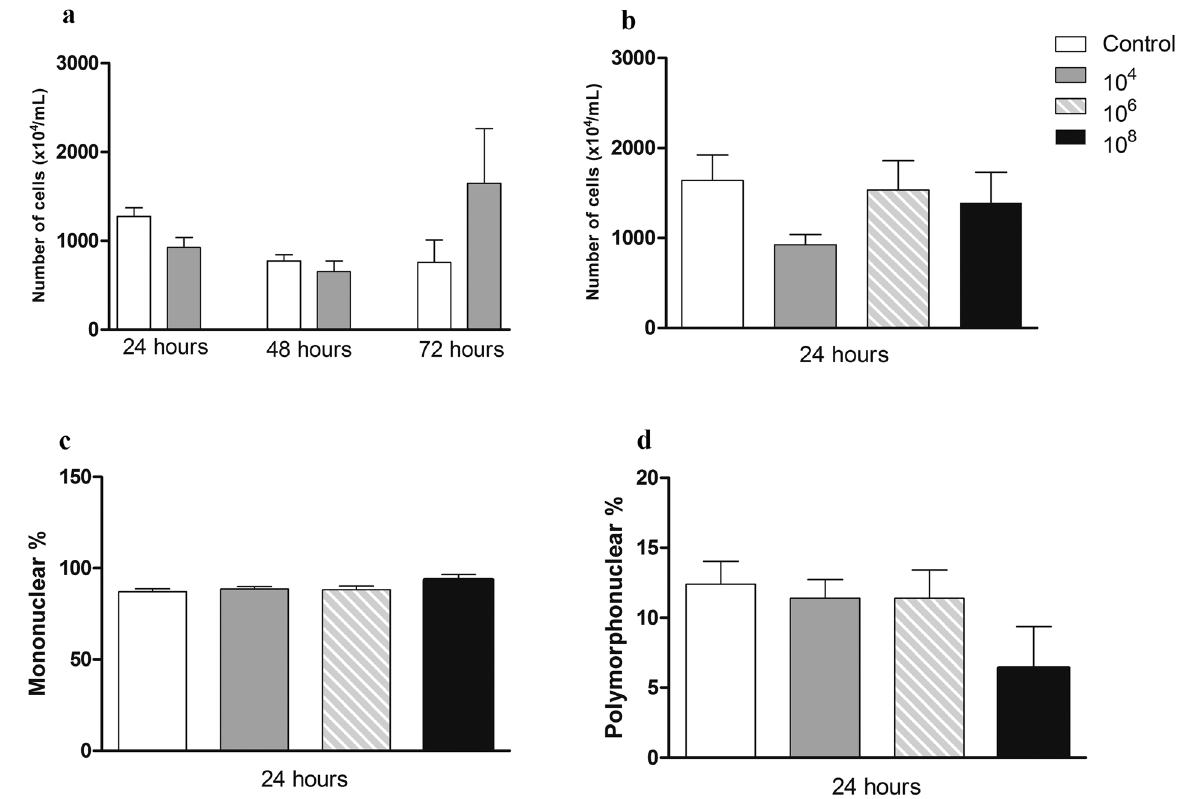
Figure 1 - Count of blood cells. A/J mice were infected with intrauterine doses of 10 4 , 10 6 or 10 8 U. diversum . Twenty four, 48 and 72 hours after infection, the animals were euthanized and blood samples were collected. Immediately after euthanasia, the total number of cells was determined in Neubauer chamber. For the differential counts, slides were stained with panotic and counting was performed with a light microscope using 1000x magni fi cation. Cells were characterized and differentiated, and the percentage was estimated according the total number of cells. ( a ) and ( b ) total number of leukocytes. ( c ) Percentage of mononuclear. ( d ) percentage of polymorphonuclear cells. n